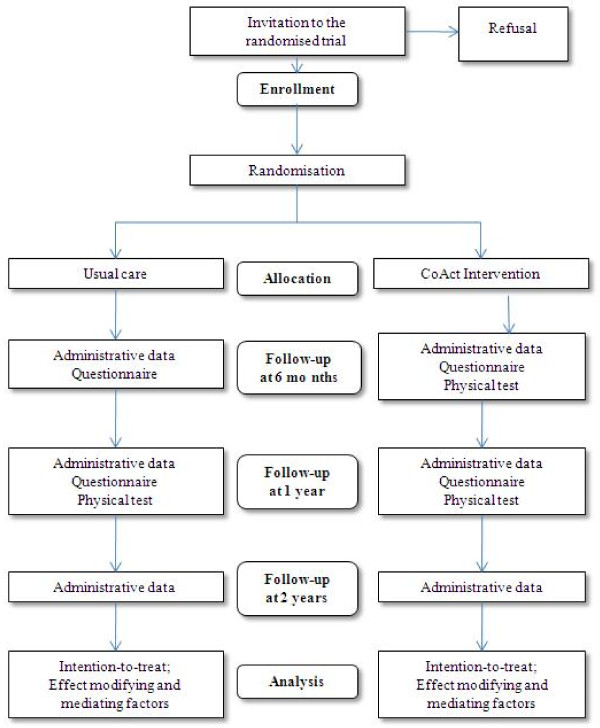
Research design.